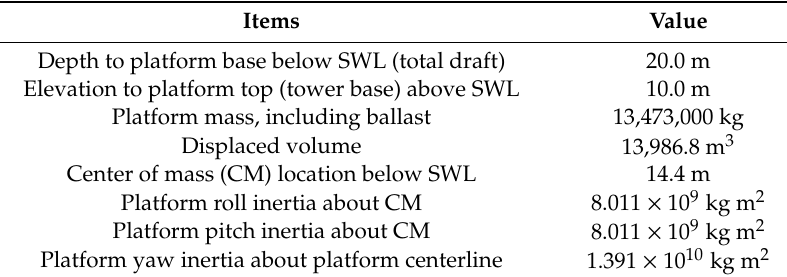
Table 2. Platform properties in OC4.